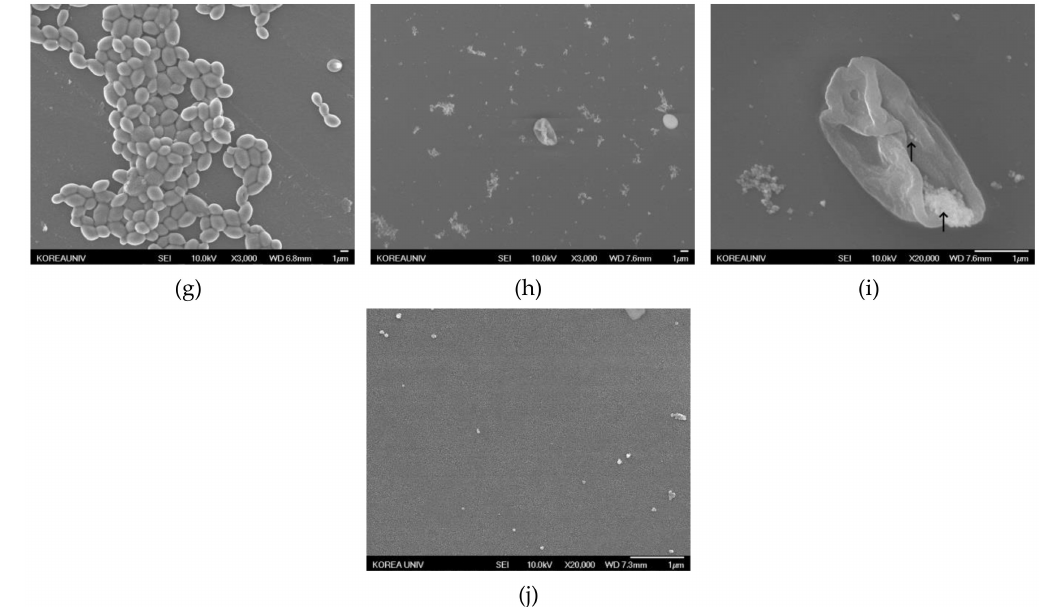
Figure 7. SEM images of Candida species treated with silver nanoparticles: ( a ) untreated C. albicans (3000 × magnification); ( b ) C. albicans treated with 64 µ g / mL silver nanoparticles (3000 × magnification); ( c ) C. albicans treated with 64 µ g / mL silver nanoparticles (20,000 × magnification); ( d ) untreated C. parapsilosis (3000 × magnification); ( e ) C. parapsilosis treated with 64 µ g / mL silver nanoparticles (3000 × magnification); ( f ) C. parapsilosis treated with 64 µ g / mL silver nanoparticles (20,000 × magnification); ( g ) untreated C. albicans (3000 × magnification); ( h ) C. glabrata treated with 64 µ g / mL silver nanoparticles (3000 × magnification); ( i ) C. glabrata treated with 64 µ g / mL silver nanoparticles (20,000 × magnification, AgNPs are shown as black arrows); and ( j ) control image of AgNPs (20,000 ×